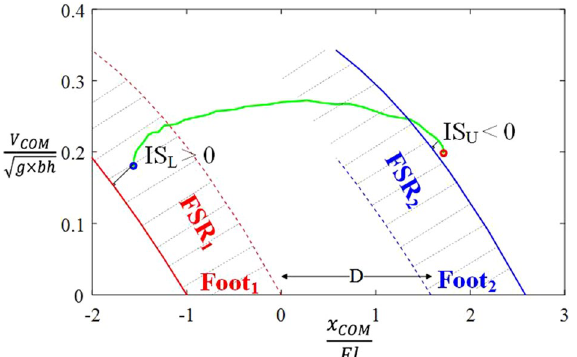
Figure 2. Extended Feasible Stability Region (ExFSR), along with the body’s COM motion states for the duration of an entire step. The ExFSR is the area between the solid red and blue lines that included FSR 1 and FSR 2 (shaded areas). The COM state trajectory is shown as a green line between Foot 2 ’s toe-off instant (hollow blue circle) to Foot 1 ’s toe-off instant (hollow red circle). The indexes of stability ( IS L (n) and IS U (n) ) illustrate how close the individual can be to backward and forward loss-of-balance, respectively, for the duration of a step. In the experiments, the distance between Foot 1 ’s toe tip to Foot 2 ’s heel (D) was measured using the reflective markers attached to each foot. The COM position and velocity values are referenced with respect to Foot 1 ’s toe (stance foot during the swing phase before double support).